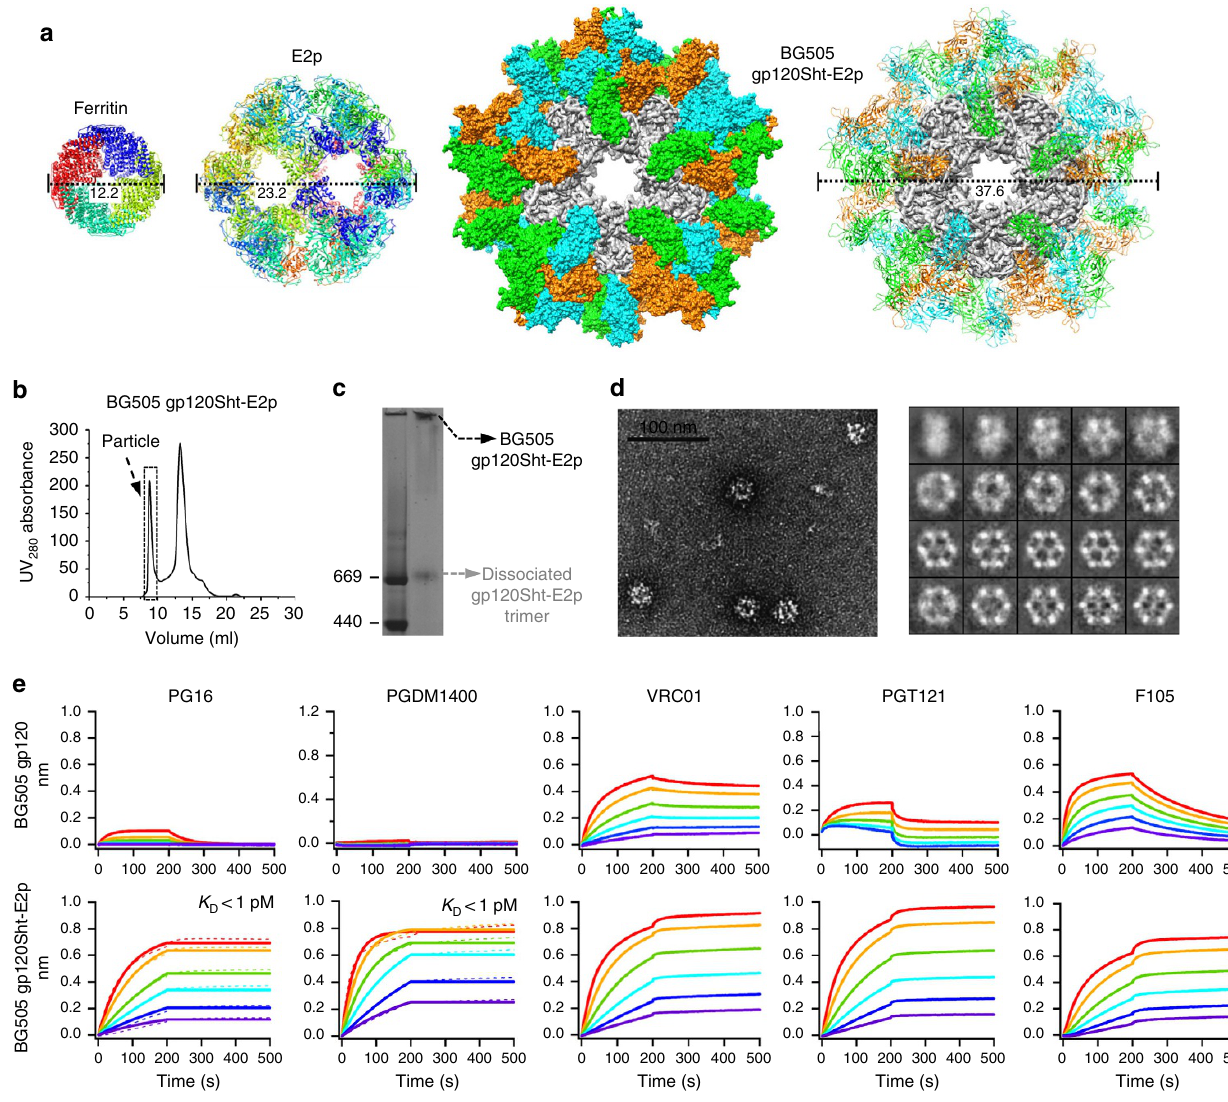
Figure 3 | Design and characterization of 60-meric gp120-E2p nanoparticle. ( a ) Structural models of FR, E2p and gp120Sht-E2p nanoparticles. The ribbon models of FR and E2p are colour-coded based on protein chains. For gp120Sht-E2p, the surface model of protein particle is shown on the left, whereas the ribbon model of trimeric gp120 spikes is shown on the right. E2p and three gp120 chains within each trimeric spike are coloured in grey, cyan, green and orange, respectively. ( b ) SEC profile of gp120Sht-E2p from a Superose 6 10/300 GL column. Fractions used for EM and antigenic analyses (8.5–9.75ml) are indicated with a dashed box. ( c ) BN-PAGE of gp120Sht-E2p with both nanoparticle and potentially dissociated trimer bands labelled. ( d ) Micrograph (left) and 2D class averages (right) of gp120Sht-E2p derived from negative-stain EM. ( e ) Octet binding of monomeric gp120 and gp120Sht-E2p to a panel of bNAbs and non-NAbs, with additional antibody binding data shown in Supplementary Fig. 3. Sensorgrams were obtained from an Octet RED96 instrument using a titration series of six starting at the maximum of 15nM for gp120Sht-E2p. K D values are calculated from 1:1 global fitting for apex-directed bNAbs PG16 and